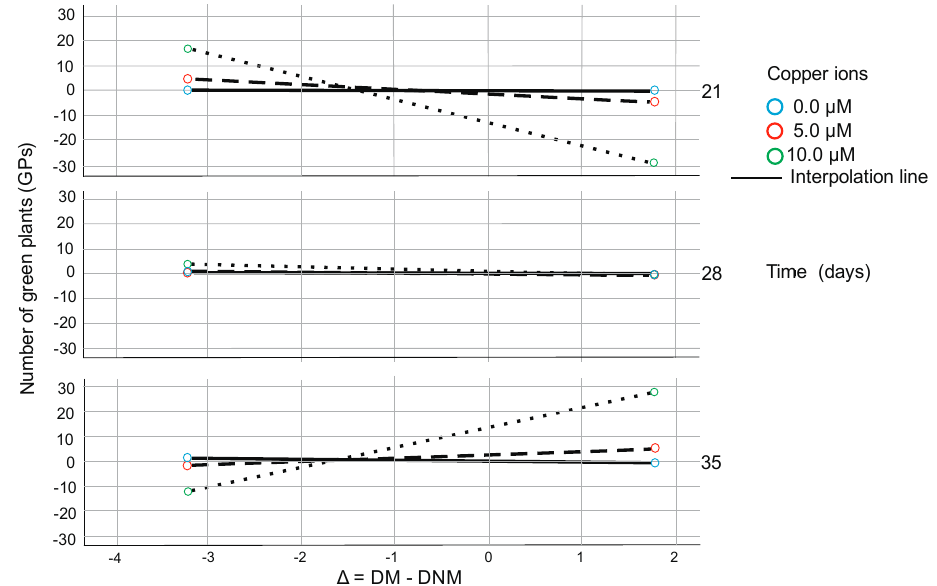
Figure 2. The conditional e ff ect of Delta on the number of green plants (GPs) derived per 100 spikes as a function of copper ion concentration and Time of in vitro anther culture from moderated moderation model. The category axis (axis of abscissa) is indicated as Delta ( ∆ ). It illustrates the values of Delta expressed as DM-DNM in percentage. Axis of ordinates reflects the number of green plants (GPs) regenerated per 100 anthers expressed in a number of regenerants. Blue, red and green circles indicate the di ff erent concentrations of silver